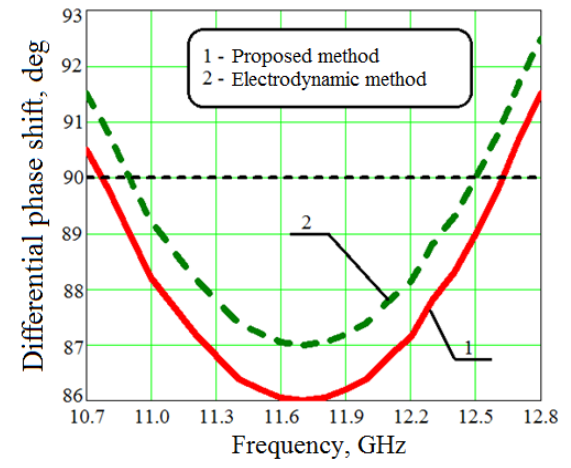
FIGURE 7. The differential phase shift of waveguide polarizer with three diaphragms